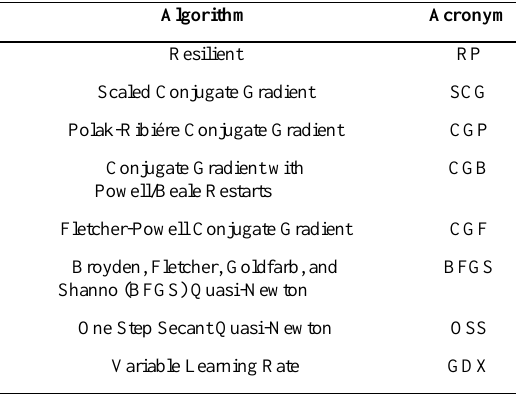
Table 2. Eight different training algorithms used for training of MLP neural